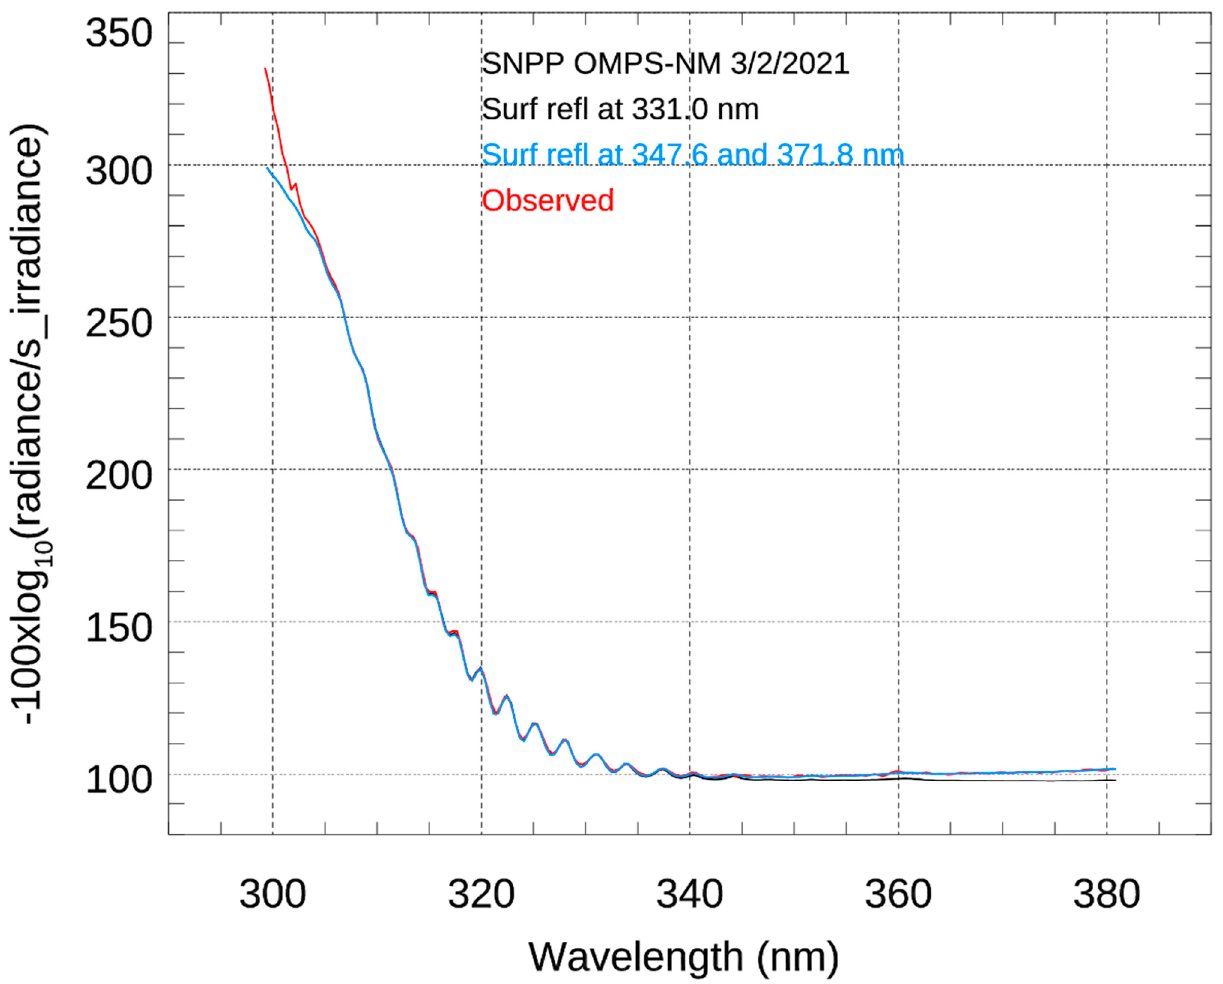
Figure 6. N value for OMPS NM measurements (red), CRTM simulation using a constant surface reflectance (black), and CRTM simulations using interpolated/extrapolated surface reflectance from the estimated reflectance at two wavelengths (cyan).